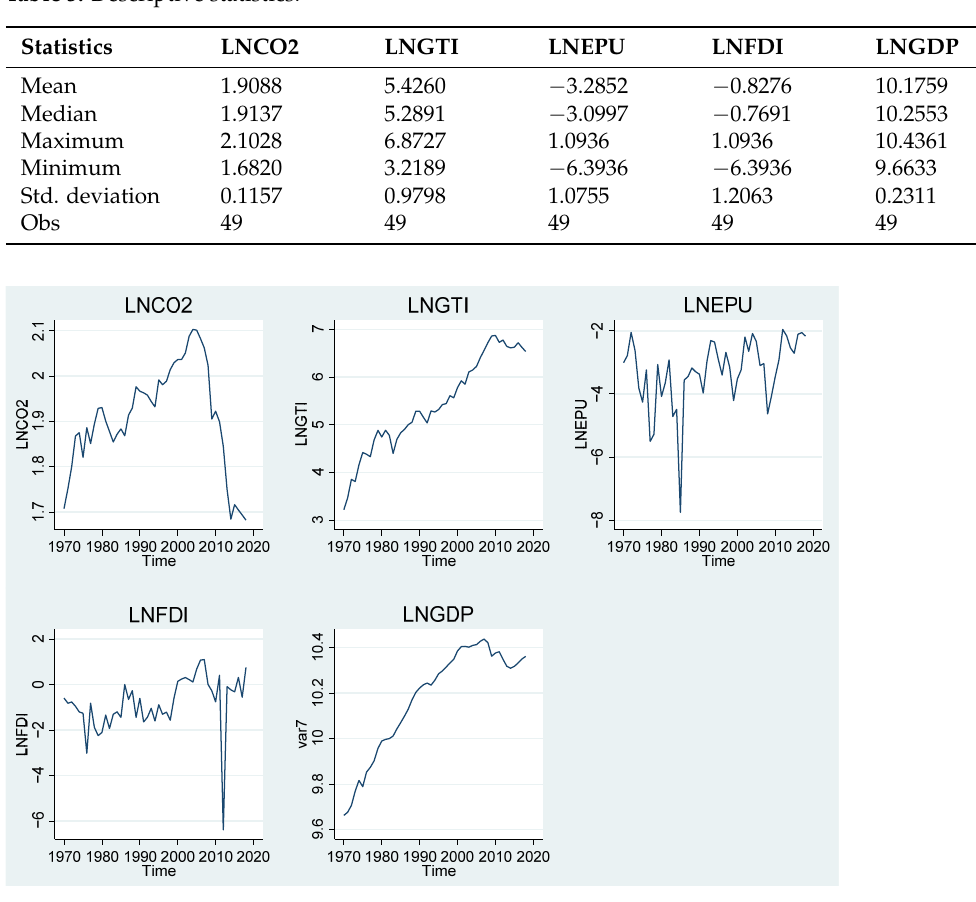
Figure 3. Annual time series trend